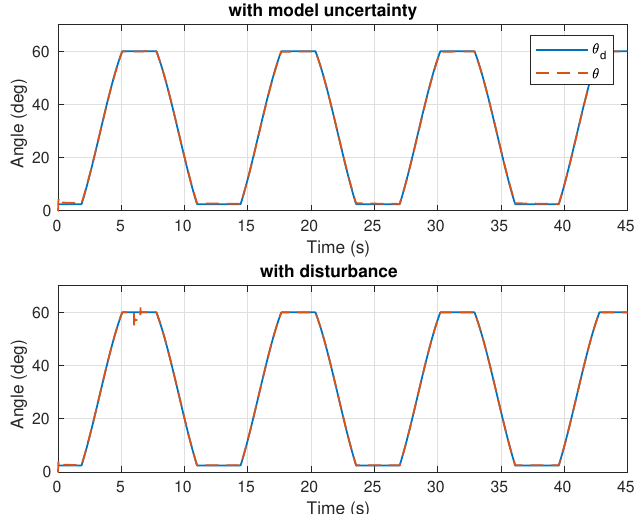
Figure 15. Simulation results on trajectory tracking on manipulator with model uncertainty and